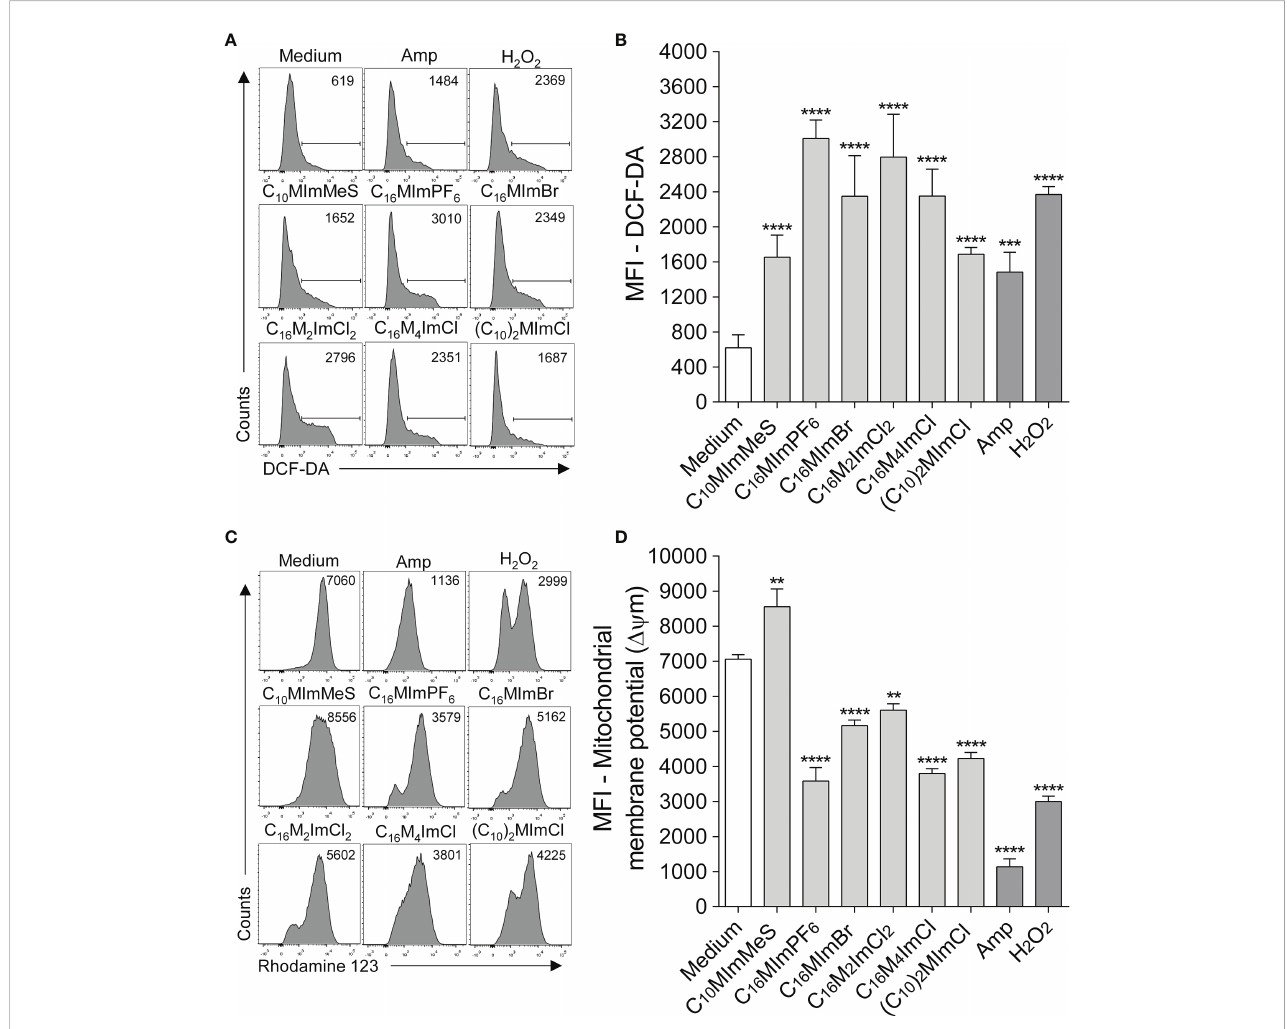
FIGURE 3 Determination of intracellular ROS (A, B) and mitochondrial membrane potential ( DY m) (C, D) of L. amazonensis promastigotes incubated with imidazolium salts. Promastigote forms in the logarithmic phase (2 x 10 5 cells/well) were incubated or not with 2-fold IC 50 value of IS at 26°C for 6 h. M199 was used as negative control, and amphotericin B (0.4 µM) and H 2 O 2 (2 mM) as positive controls. Data are expressed as means ± SEM and are representative of three independent experiments. The One-way ANOVA test followed by the Bonferroni ’ s test were applied. **p < 0.01, ***p < 0.001 and ****p < 0.0001 when compare with the medium